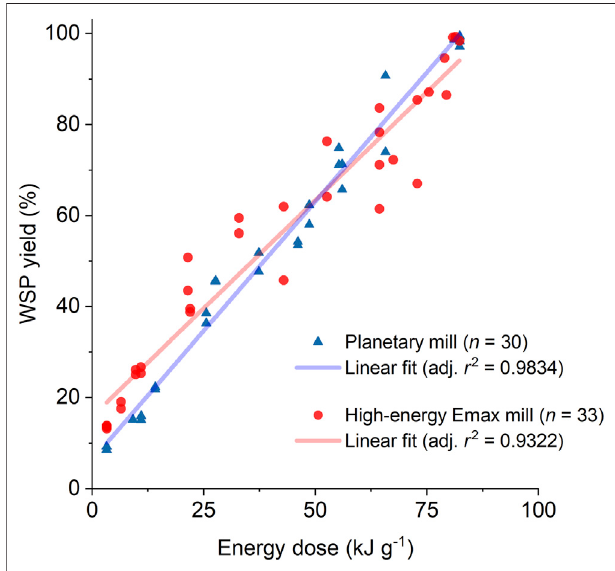
FIGURE 3 | Comparison of MCD data from the experiments carried out in the high-energy Emax mill (Kessler et al., 2018) and the planetary ball mill (displaying the results from the linear regime) under varied conditions, and the linear fi tfor each dataset. Milling conditions arelisted in Supplementary Table S1 and Supplementary Table S2